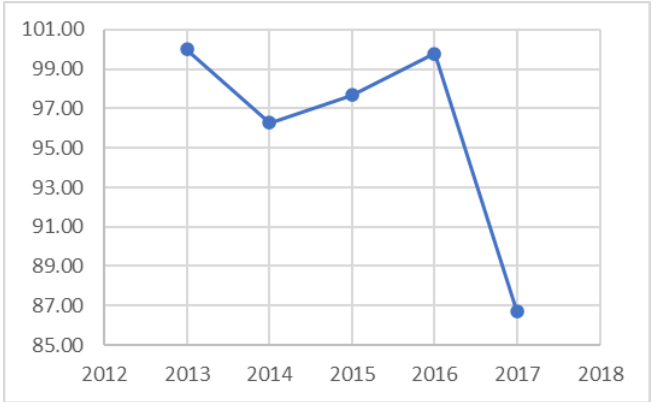
Figure 12 . The 2013 – 2017 exergy destruction in Italy. For the 2013 value, 1252.85 × 10 12 kJ is set to 100% .